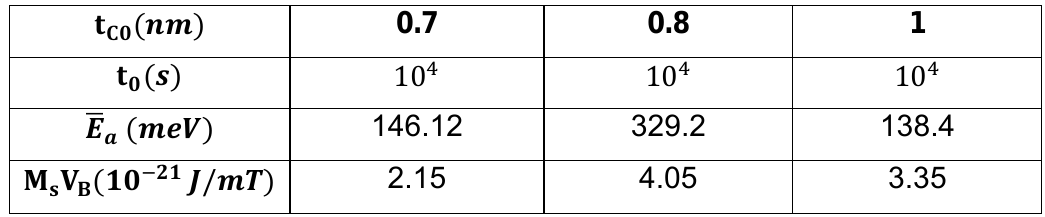
Figure 1. 𝑡 depending on μ H and it fitting by Arrhenius-Néel law Eq. (2), for 1/2 0 the three samples Table 2 . Data from the fitting byArrhenius-Néel